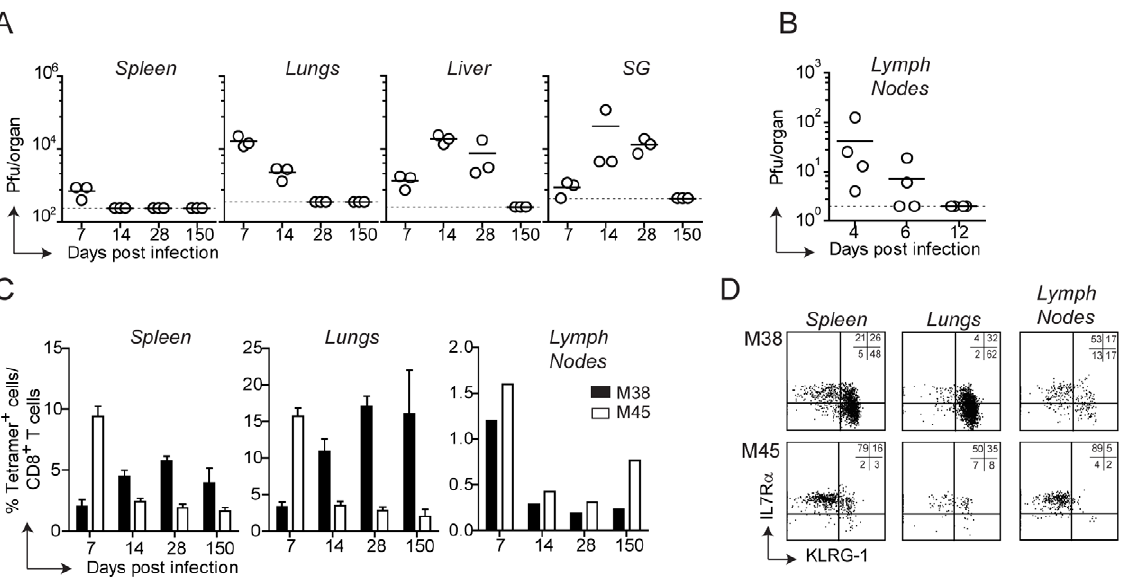
Figure 1. Tissue-specific pattern of MCMV-specific CD8 T cell responses. (A) C57BL/6 mice were infected with MCMV- D m157 and virus titers were determined in the spleen, lungs, liver and salivary glands (SG) at days 7, 14, 28 and 150. In a separate experiment, virus titers were determined in the axillary lymph nodes at days 4, 6 and 12 post infection (B). The horizontal lines represent the respective detection limits. (C) The percentage of M38- (black bars) and M45-specific CD8 T cells (white bars) were measured by tetramer staining in the spleen, lungs and inguinal lymph nodes at the indicated time points post MCMV infection. For spleen and lungs, bars show averages of three mice per group 6 SEM, whereas for lymph nodes bars represent cells pooled from three mice. (D) Representative plots showing KLRG-1 and IL7R a expression on M38- and M45-specific CD8 T cells in the spleen, lungs and inguinal lymph nodes on day 150 post infection. All data are representative of at least three independent experiments.